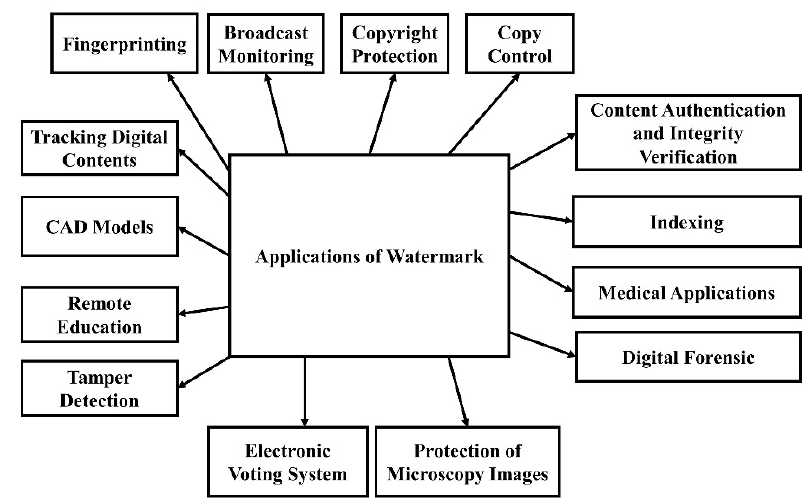
Figure 4. Related applications of digital image watermarking.